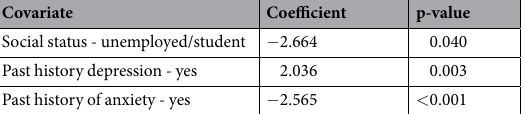
Table 6. Significant covariates of a linear model for the difference of antenatal to postpartum (DPA) EPDS scores. The full model is provided in Suppl. Table 7.